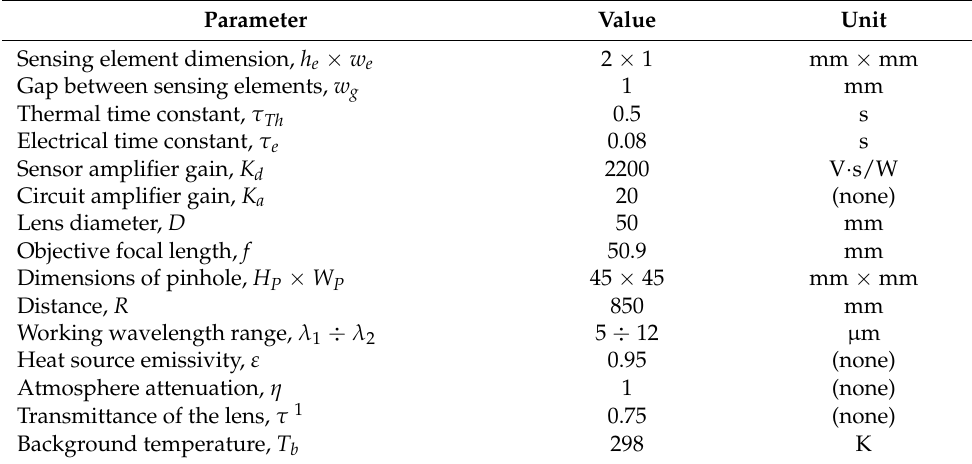
Table 1. Parameter values for simulation.